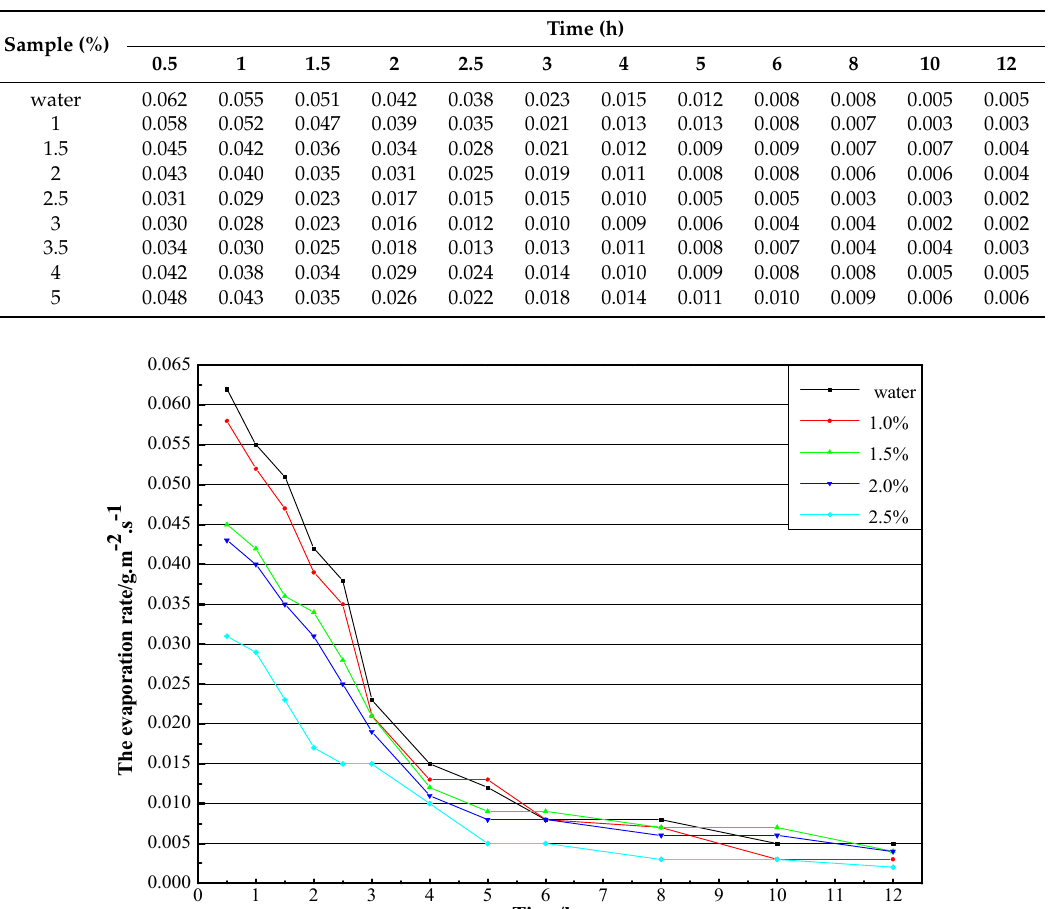
Table 3. Evaporation rate of dust suppressant (g · m − 2 · s − 1 ).